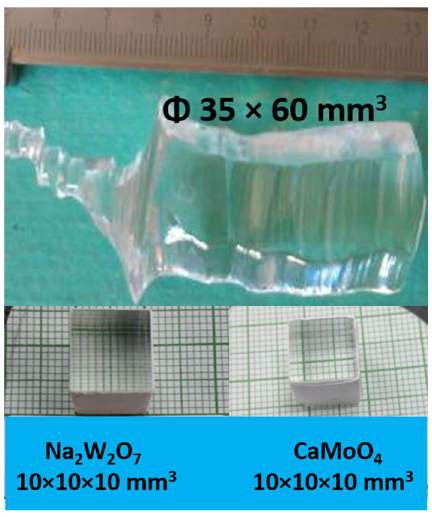
Fig. 1 Photographic views of grown NWO crystal and measured sam- ples of NWO and CMO crystals